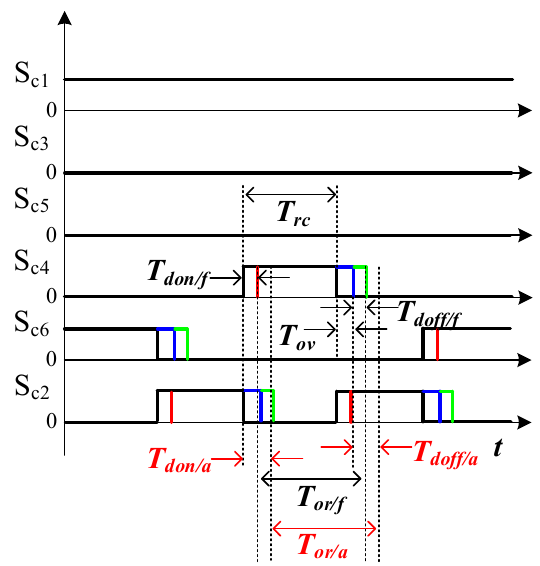
Figure 32. Gating signals of CSI.